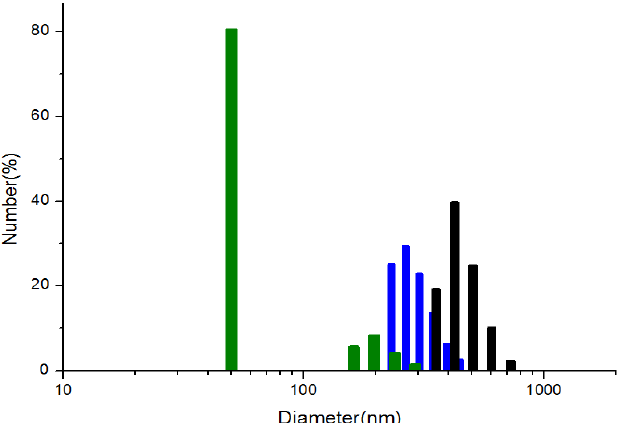
Figure 6. Particle size distribution diagrams of the ZnS:Mn-MAA NCs prepared at pH 2 (blue), pH 7 (green), and pH 12